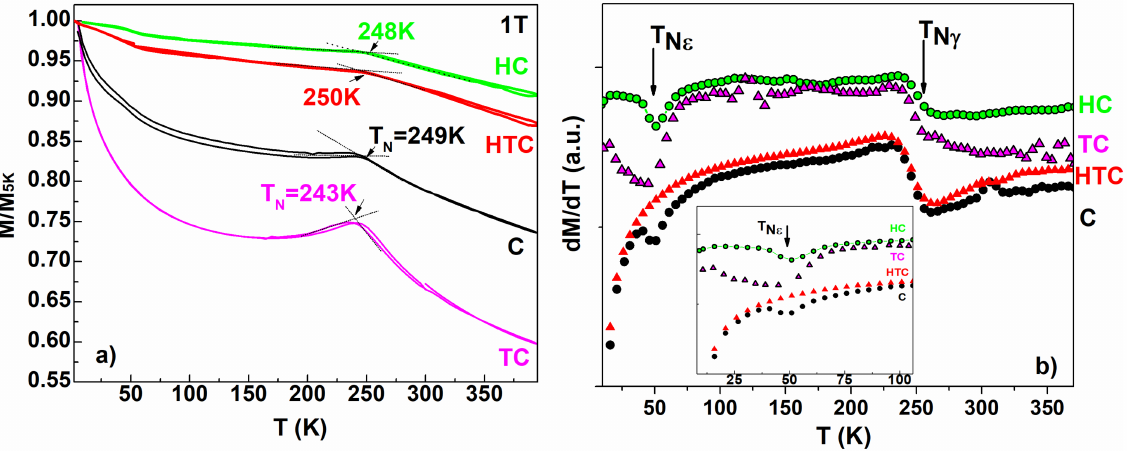
Figure 7. ( a ) The thermo-magnetic measurements at low temperature in 1T applied magnetic field on all investigated samples. ( b ) The first derivative of magnetization